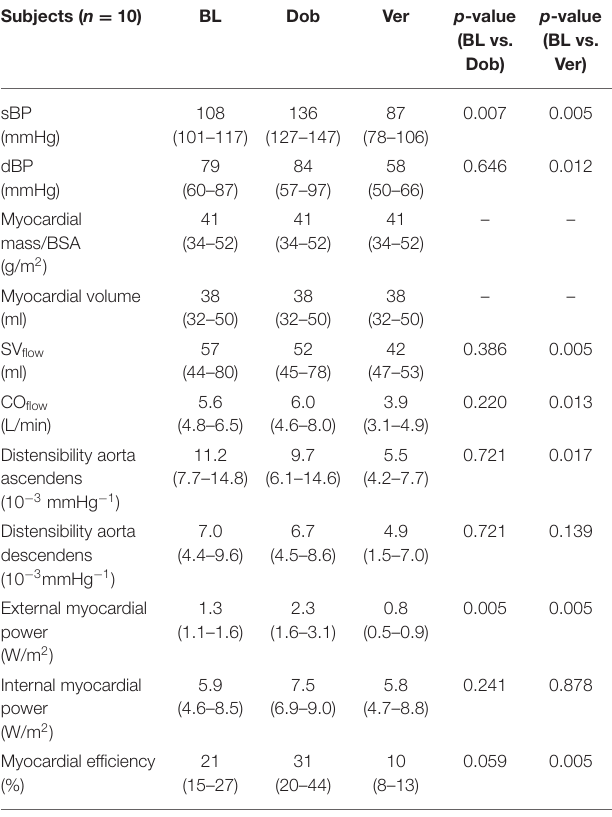
TABLE 1 | Clinical characteristics, cardiac magneic resonance geometric and functional parameters, and invasively measured hemodynamic parameters of pigs at rest, under stress (dobutamine), and under ischemia (verapamil). Subjects ( n =